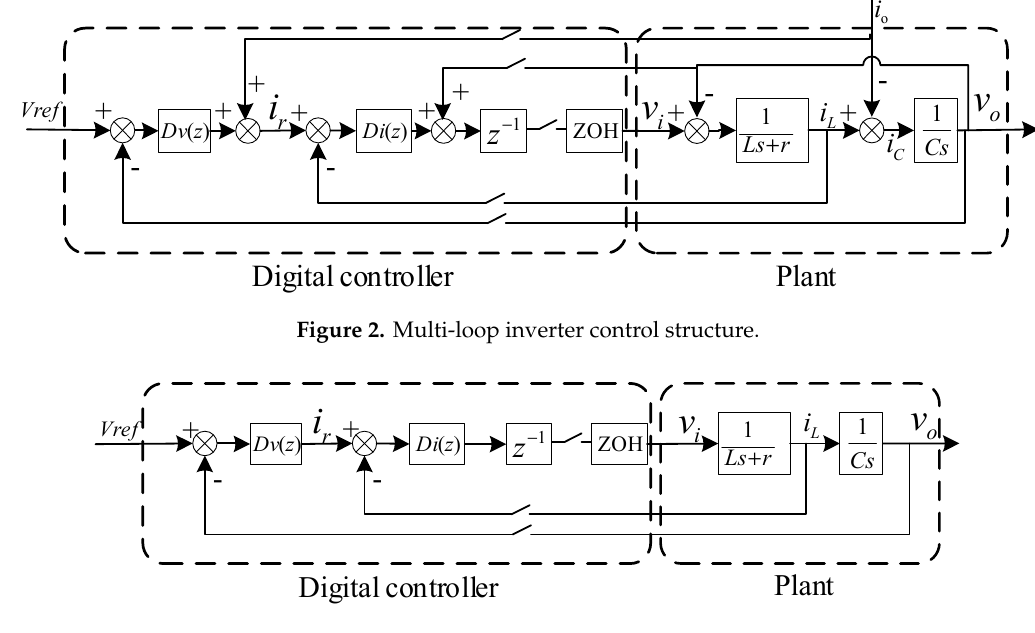
Figure 3. Simplified dual-loop control structure.